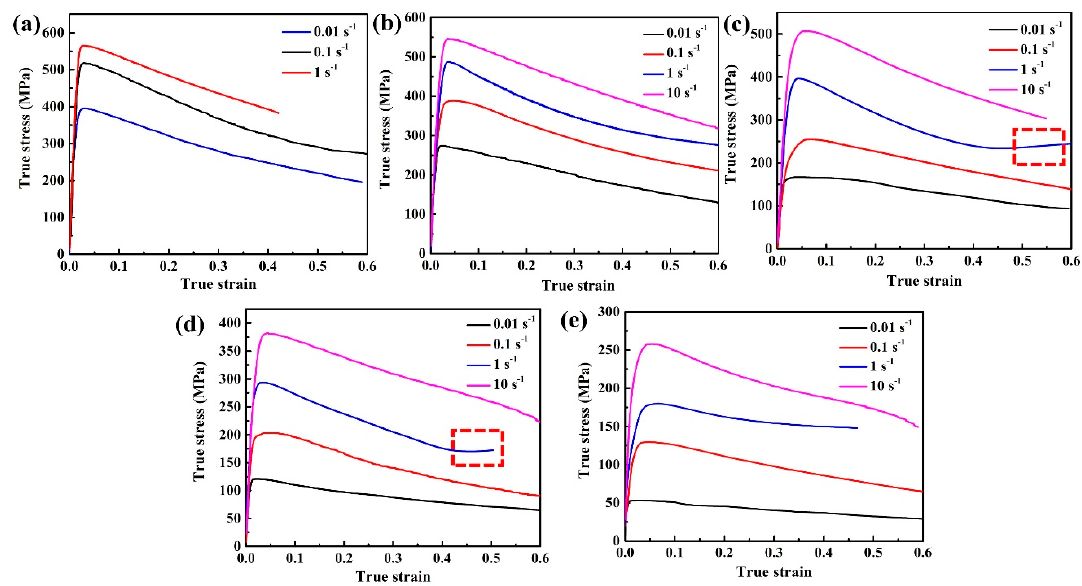
Figure 6. Flow stress ‐ strain curves of the SLMed Ti–6Al–4V alloy at different deformed temperatures higher than 700 °C: ( a ) 700 °C, ( b ) 750 °C, ( c ) 800 °C, ( d ) 850 °C, and ( e ) 900 °C.